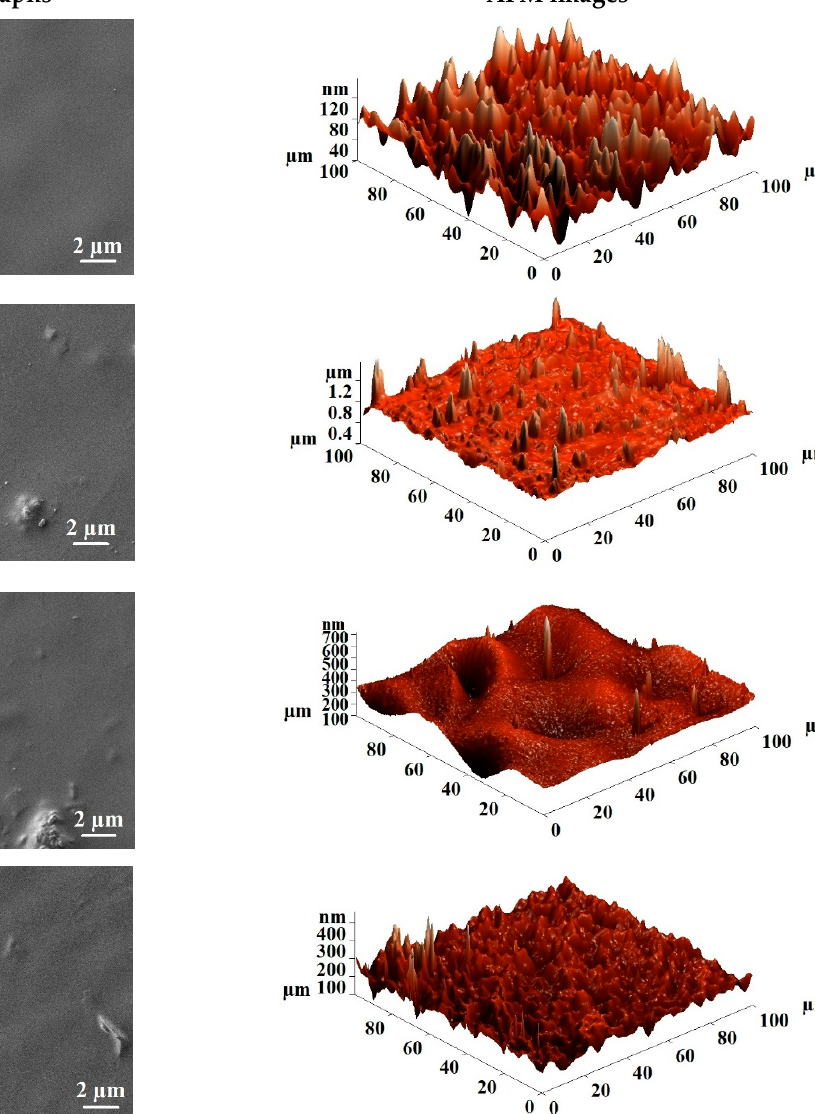
Figure 13. The AFM images and surface SEM micrographs for the cross-linked composite PVA and PVA/Zr-MOFs(10%) membranes: ( a ) PVA/GA/PAN; ( b ) PVA+MIL-140A(10%)/GA/PAN; ( c ) PVA+MIL-140A-AcOH(10%)/GA/PAN; and ( d ) PVA+MIL-140A-AcOH-EDTA(10%)/GA/PAN.